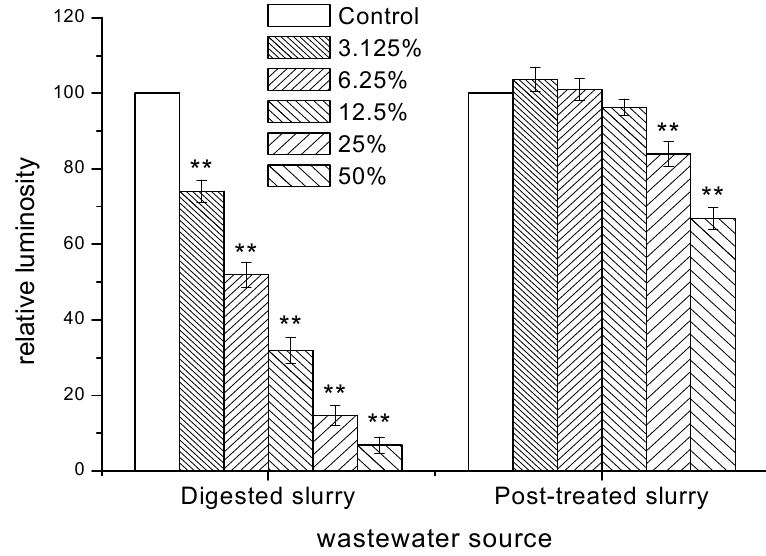
Figure 4. Variance analysis for relative luminosity of V . fischeri exposed to digested and post-treated slurry. Data are mean standard deviation; n = 3, per group. ** p < 0.01, others were no significant